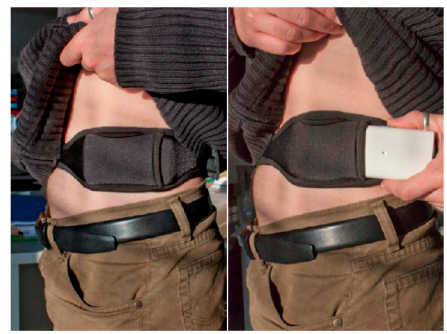
Figure 1. Image of the 9 × 2 sensor and the neoprene belt.